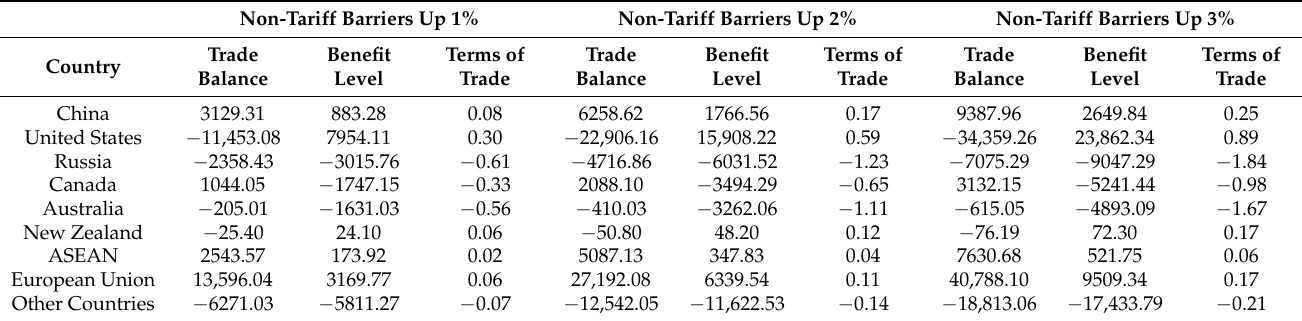
Table 12. Impact of changes in NTBs on countries’ welfare and